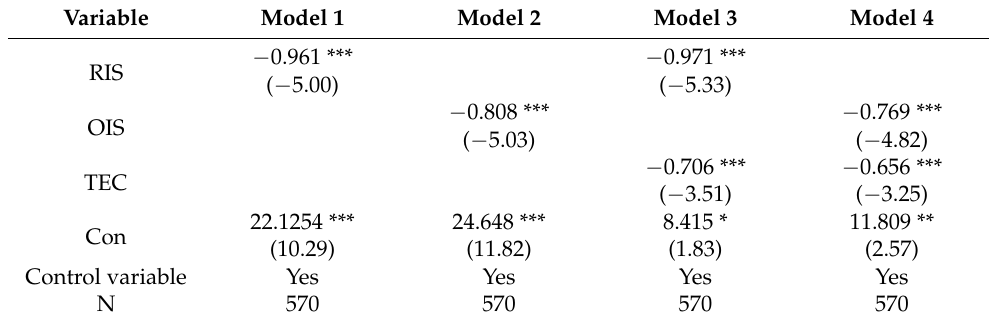
Table 6. The robustness test